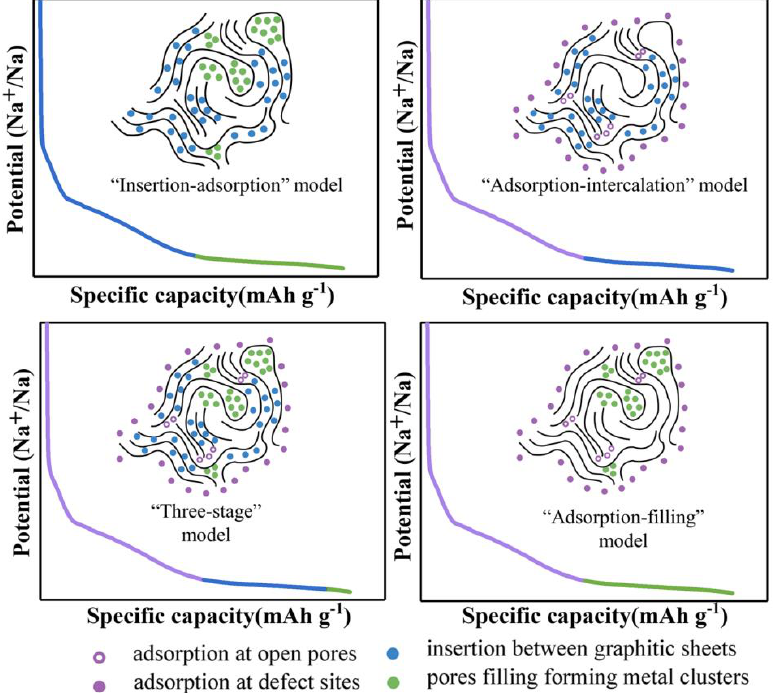
Figure 1. Four different mechanisms of sodium storage in hard carbon [77] (copyright Wiley, 2022).